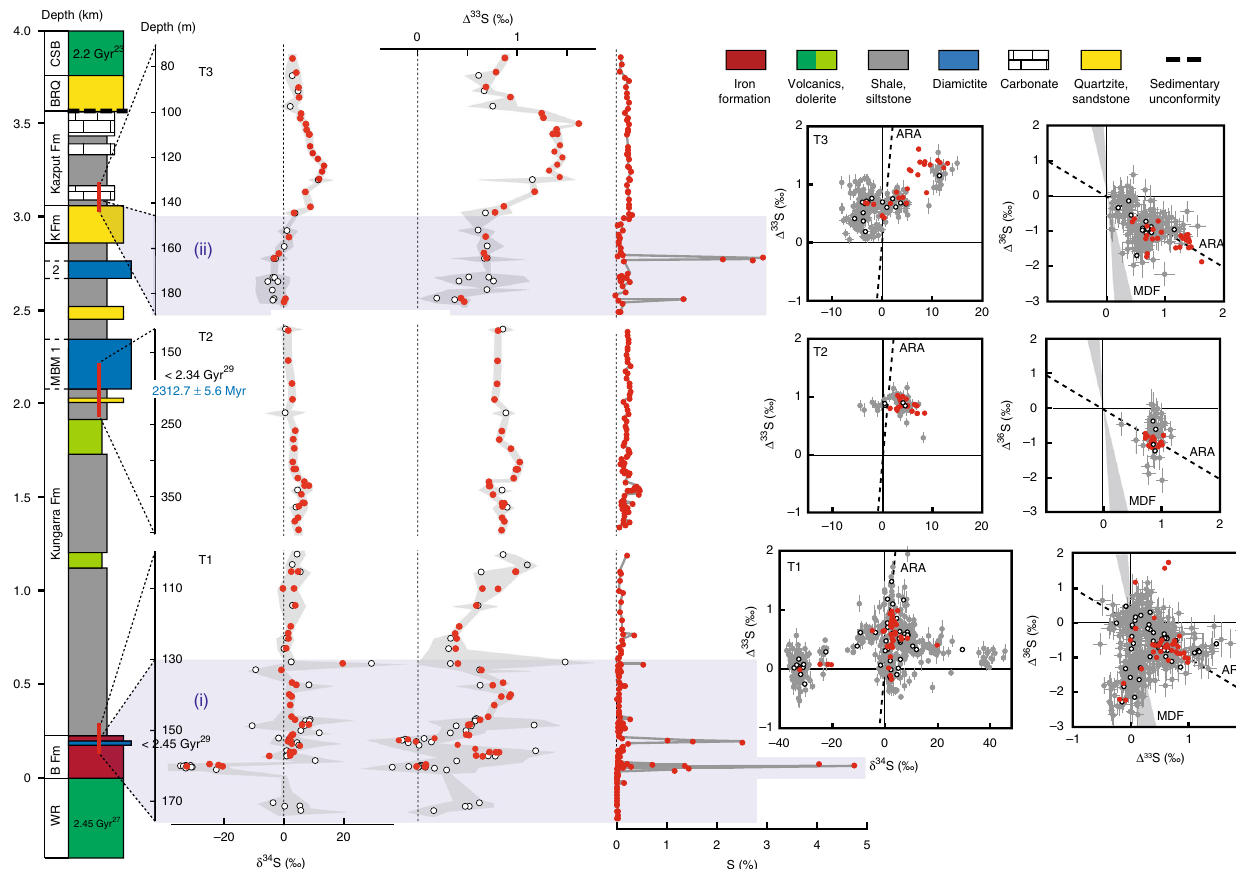
Fig. 2 Sulphur content and δ 34 S and Δ 33 S pro fi les of sulphides in the Turee Creek drill cores and associated δ 34 S- Δ 33 S and Δ 33 S- Δ 36 S compositional diagrams. Red dots, bulk analysis; white dots, mean value of in situ analysis for each sample; grey dots, individual spot analysis using the SHRIMP-SI (error bars are standard deviation of 1 σ , see Methods). The grey shaded areas in the δ 34 S and Δ 33 S pro fi les represent the range of individual spot analysis for each sample. The two blue-shaded areas labelled (i) below 130 m depth in T1 and (ii) below 145 m depth in T3 are discussed in the text. ARA, Archaean Reference Array. MDF, mass-dependent fractionation of sulphur isotopes. The stratigraphic section of the Turee Creek Group on the left is modi fi ed after Van Kranendonk and Mazumder 19 . Re-Os age of 2312.7 ± 5.6 Ma is from this study. Other age constraints are labelled accordingly. Abbreviations associated with the stratigraphic section are as follows: WR, Woongarra Rhyolite, B Fm, Boolgeeda Iron Fm., Kun, Kungarra Fm., MBM1 and 2,